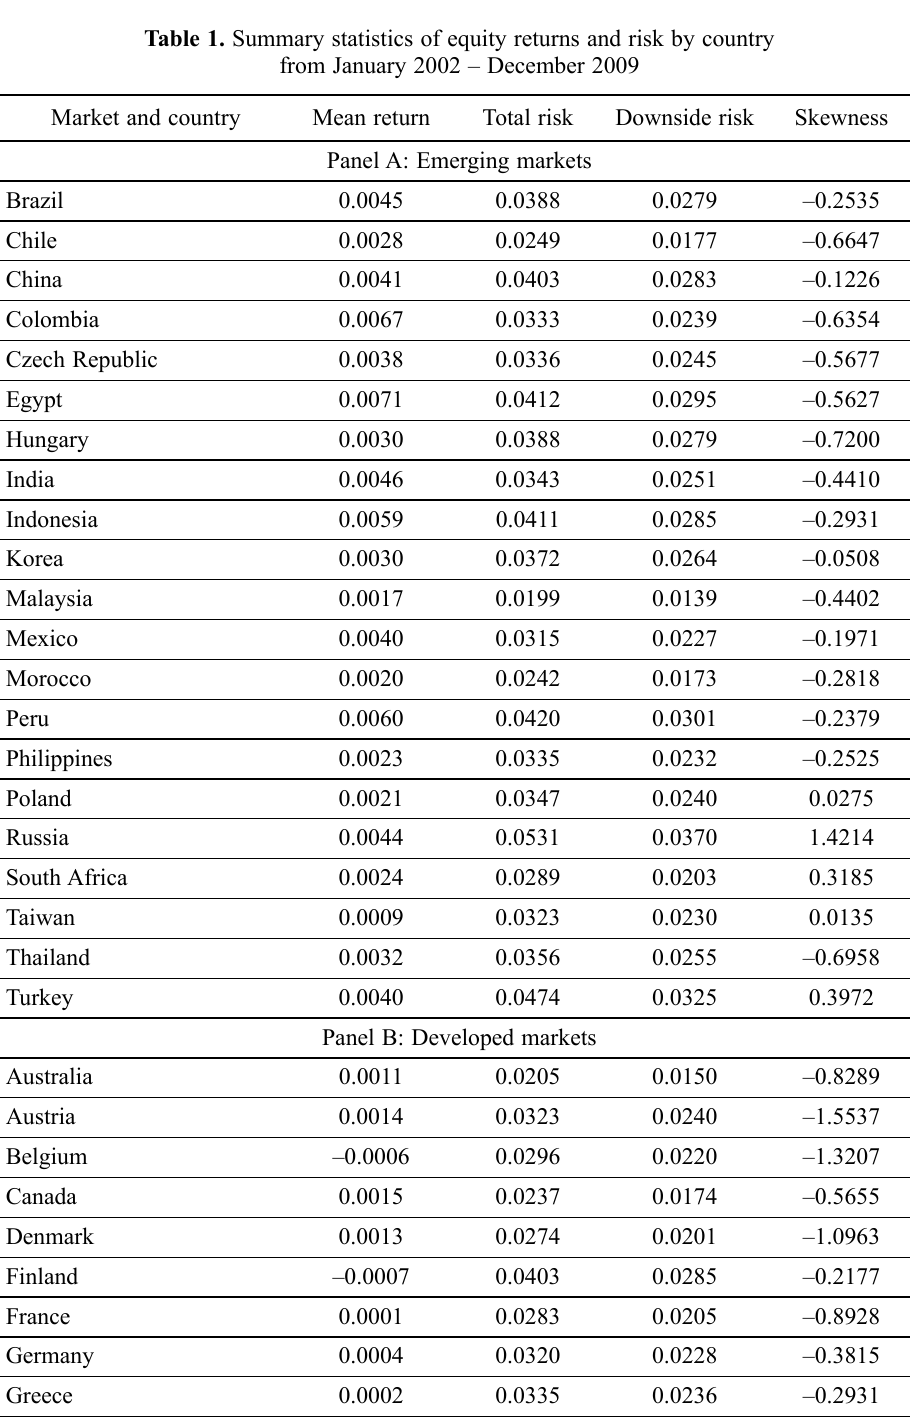
Table 1. Summary statistics of equity returns and risk by